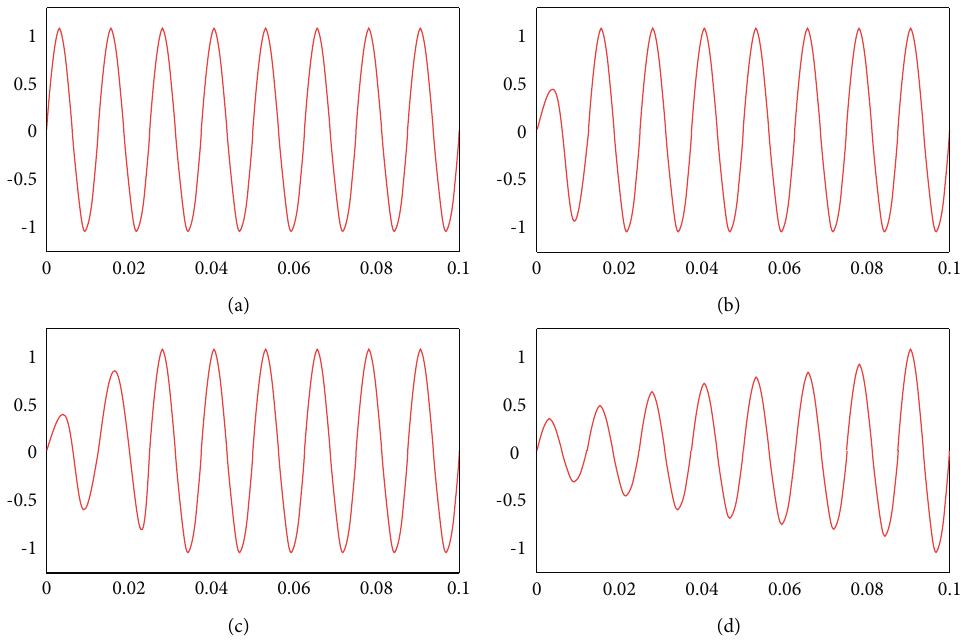
Figure 4: Time domain response of band-pass filter with different k values using SOGI. (a) Input the signal waveform. (b) The output signal time-domain response waveform at k � 1.0. (c) The output signal time-domain response waveform at k � 0.5. (d) The output signal time- domain response waveform at k �